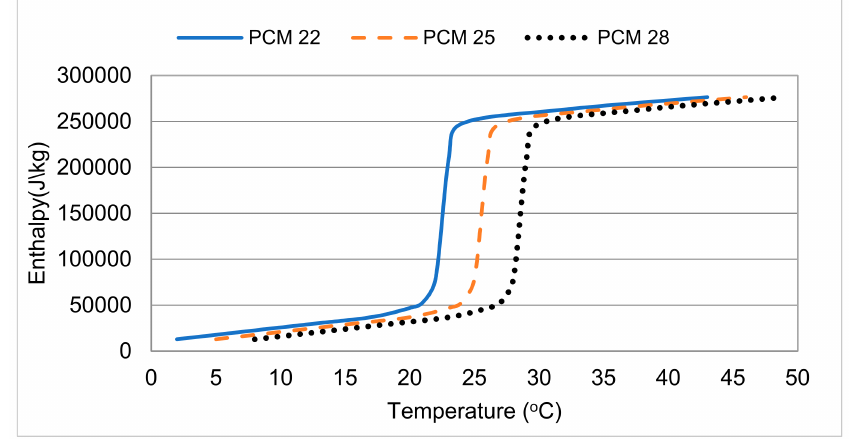
Figure 5. Enthalpy–temperature curves for PCM 22, PCM 25 and PCM